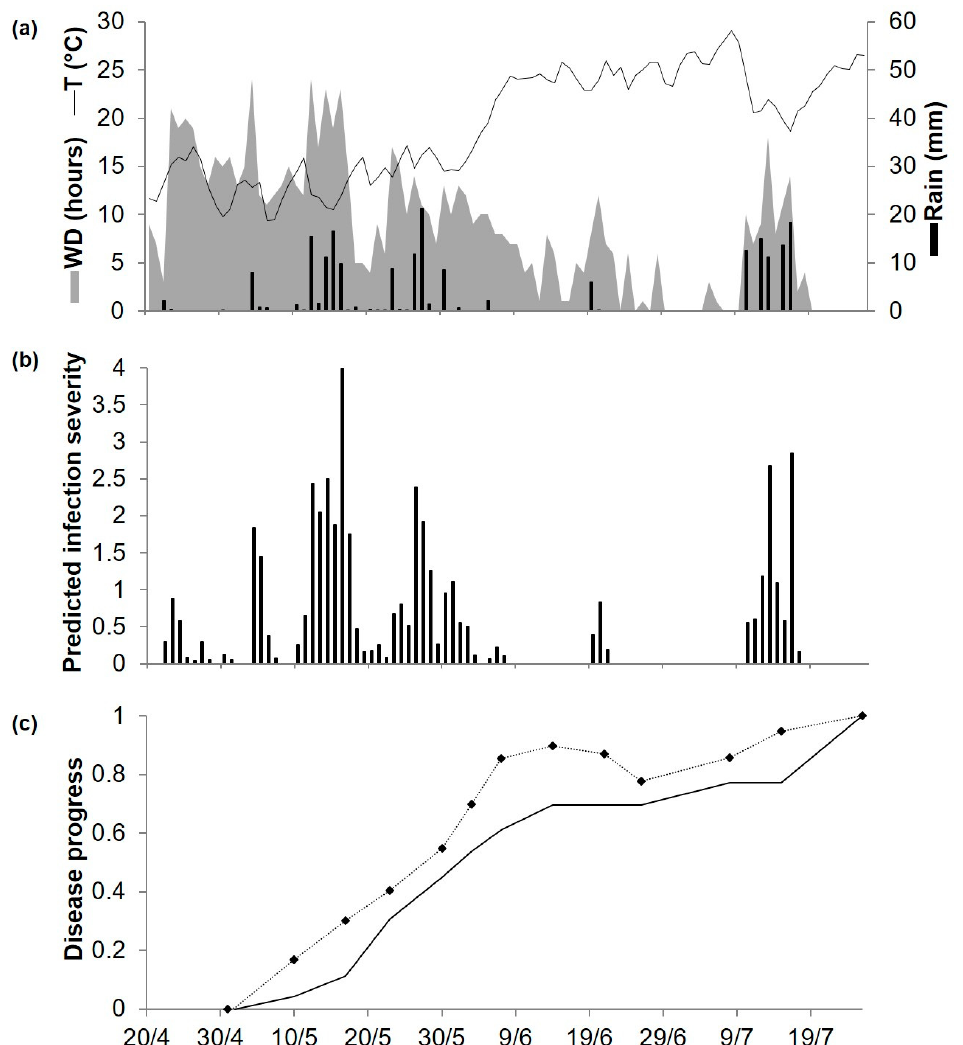
goodness-of-fit of predicted versus observed data, CCC = 0.893 and RMSE = 0.129. The model showed a slight tendency toward underestimation (CRM = 0.159).